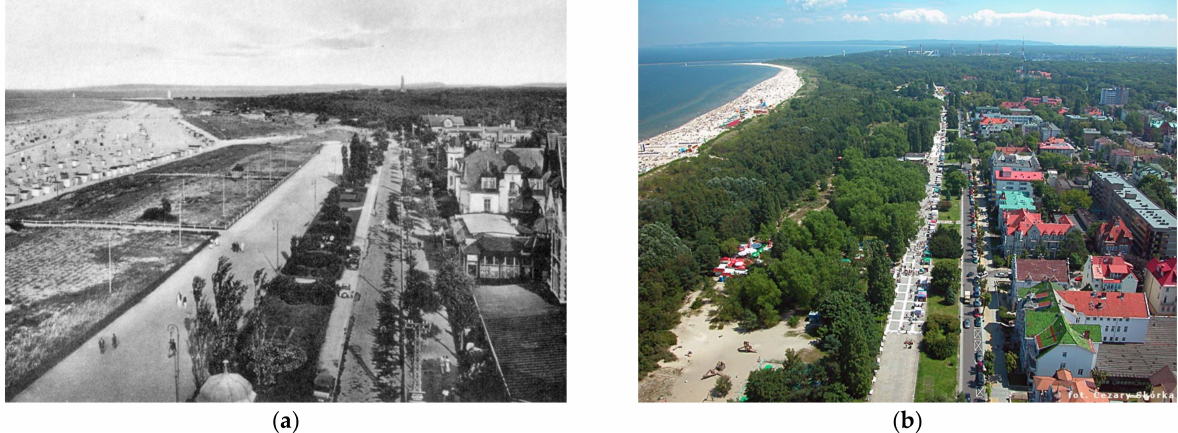
Figure 2. Linear elements: A bird’s-eye view of the promenade in Ś winouj ś cie: ( a ) A postcard from the beginning of the 20th century; ( b ) Photo from 2004. Source: Scans of archival postcards — Private collection of the author ( a ), Cezary Skórka ( b ).